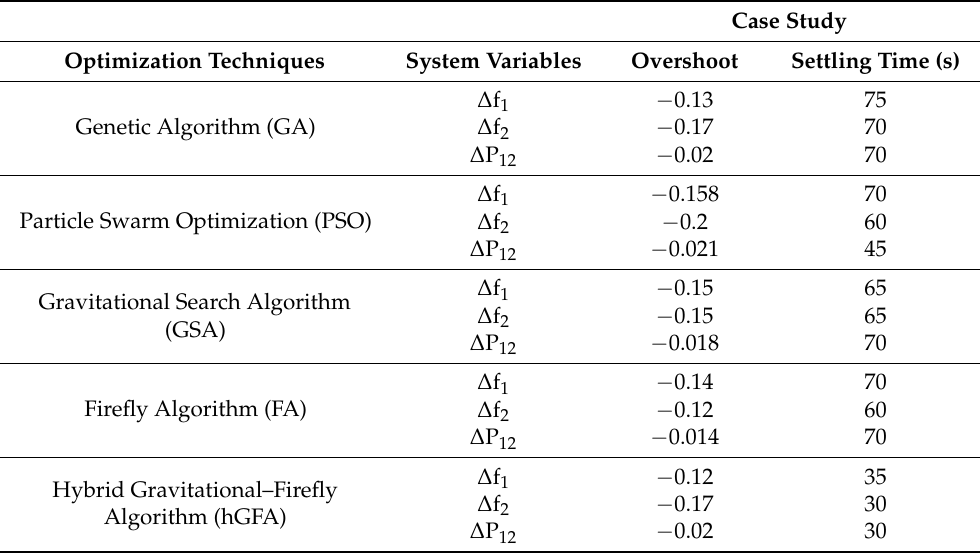
Table 4. Comparison of optimization techniques based on overshoot/undershoot and settling time for case